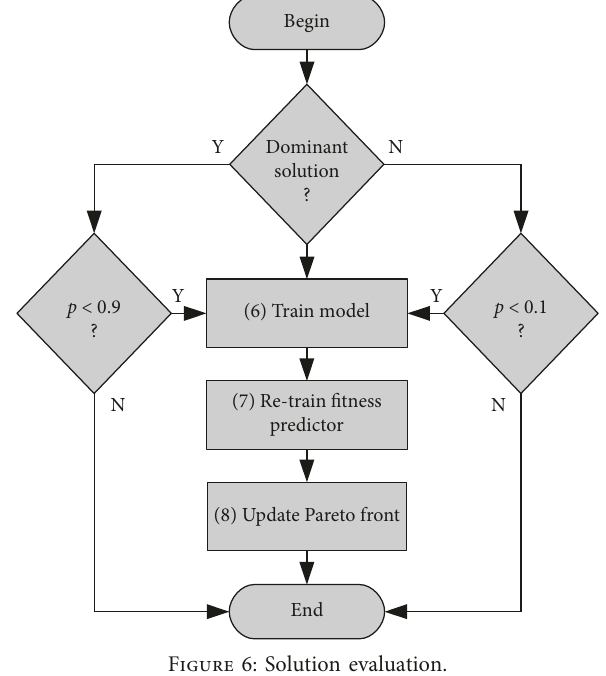
Figure 6: Solution